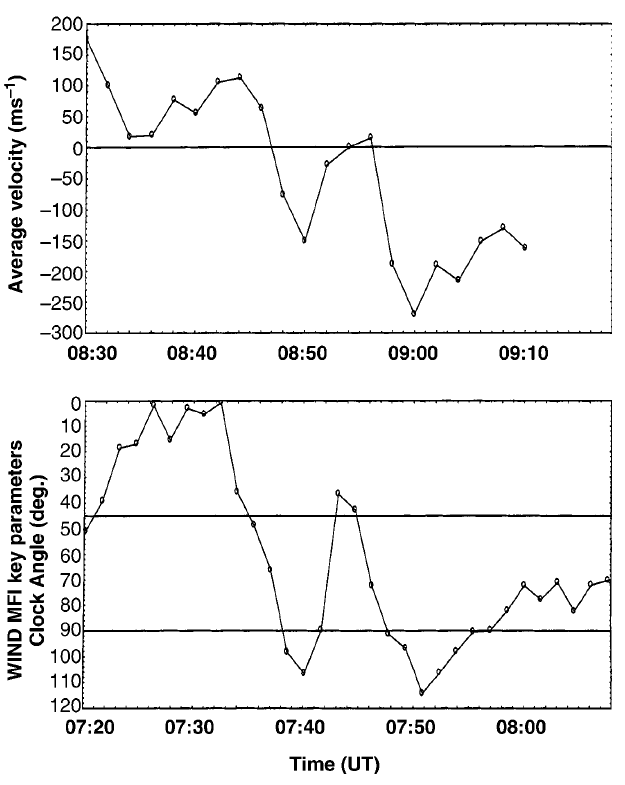
Fig. 3. Line-of-sight velocities measured by the CUTLASS Finland SuperDARN radar on the morning of 24 January, 1998 ( upper panel ). The velocities have been averaged over the general area of coincidence of the radar observations and red-line emission. Clock angle of the IMF for the morning of 24 January, 1998 ( lower panel )